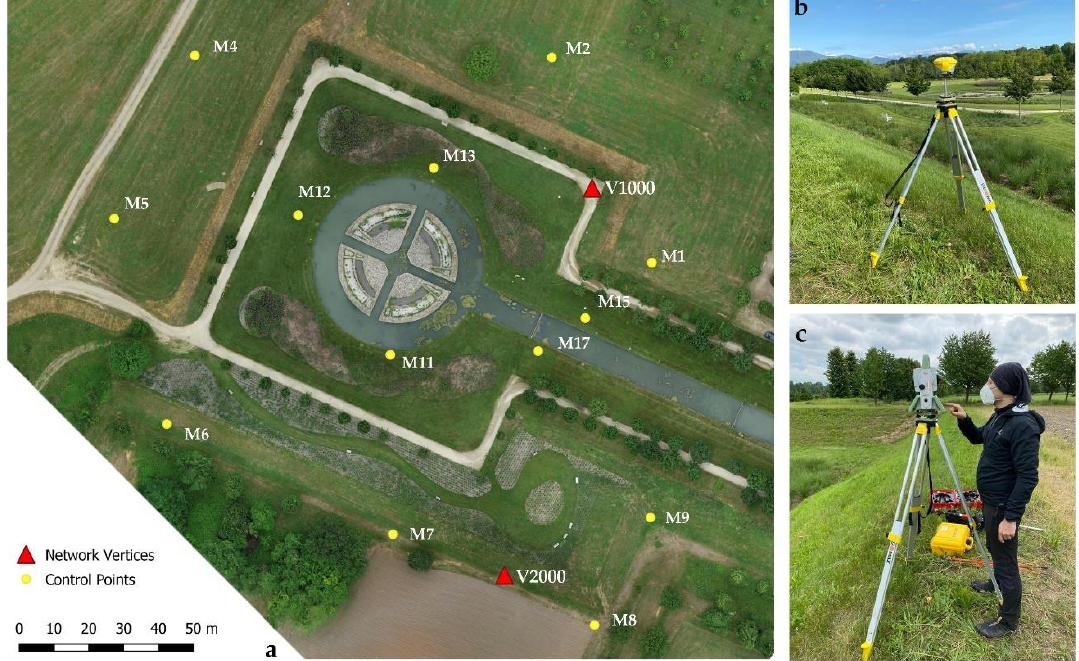
Figure 2. The two vertices of the network ( a , red triangles) and the set of control points ( a , yellow points). Some of the measurement phases on the field ( b , c ).